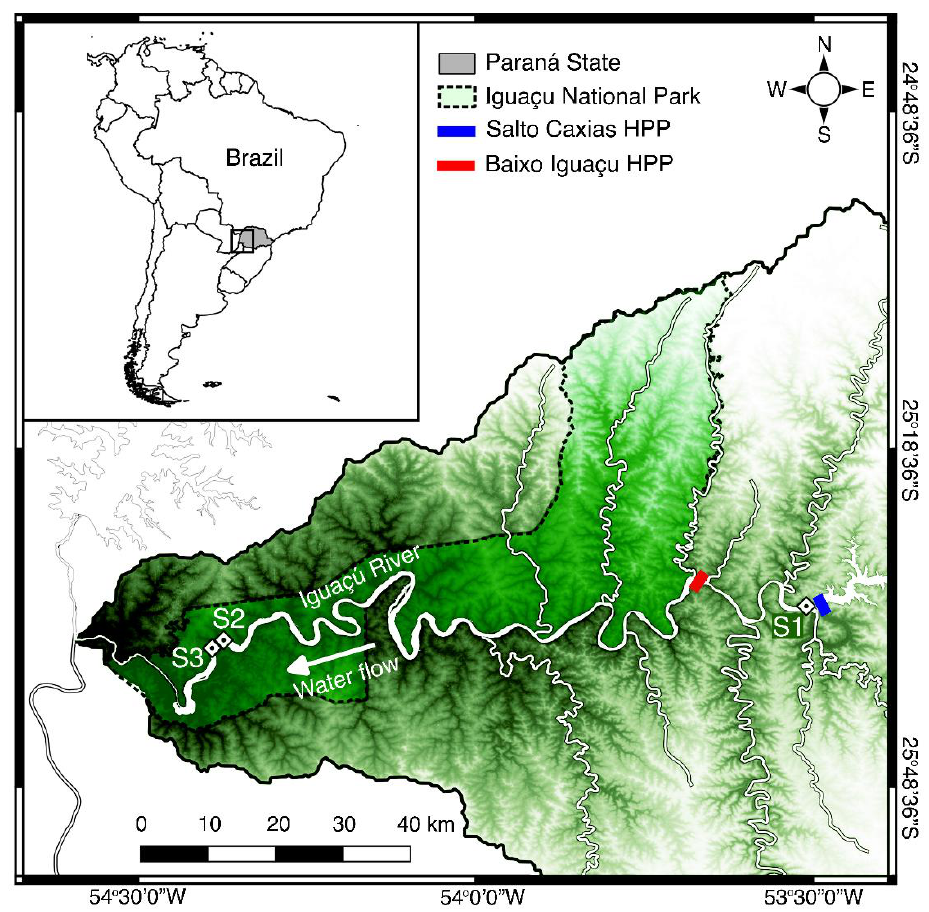
Figure 2. Map of southern South America showing sampling sites of Steindachneridion melanodermatum in the Lower Iguaçu River. The red bar represents the Baixo Iguaçu HPP, the blue bar indicates the Salto Caxias HPP, and the dashed lines indicate the Iguaçu National Park area in Brazil (Parque Nacional do Iguaçu) and Argentina (Parque Nacional Iguazú).